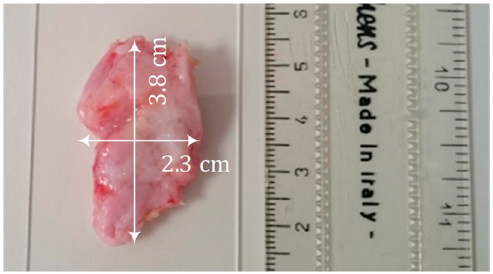
Figure 5. Cervix tissue sample with a ruler (left unit is in